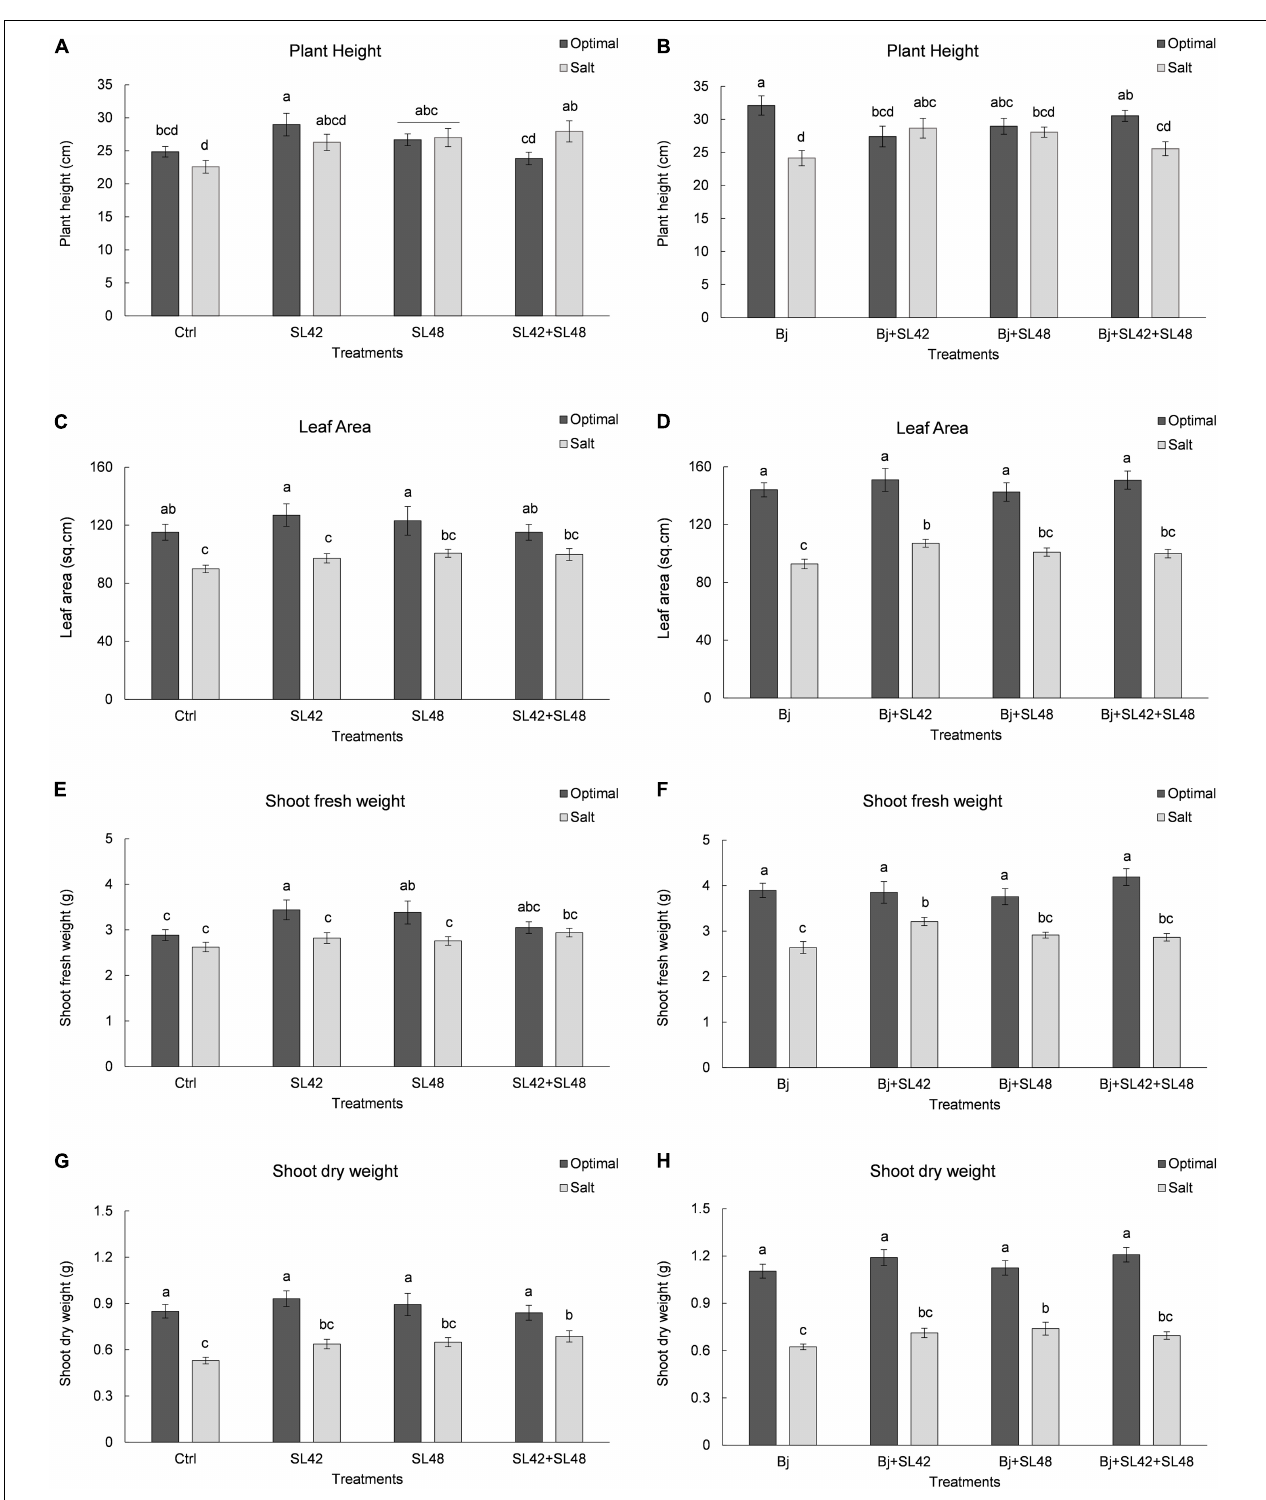
FIGURE 1 | Growth parameters of soybean plants measured at 28th DAP under optimal and salt stress conditions. (A) Plant height (C) Leaf area (E) Shoot fresh weight and (F) Shoot dry weight, seeds were treated with 10 mM MgSO 4 or bacterized with the Rhizobium sp. SL42, Hydrogenophaga sp. SL48 or co-inoculated (left). (B) Plant height (D) Leaf area (F) Shoot fresh weight and (H) Shoot dry weight, seeds were bacterized with Bradyrhizobium japonicum (Bj) as control or the strains were co-inoculated with Bj (Right). Values represent mean SE ( n = 12) and values that share the same letters are not significantly different (a = 0.05).